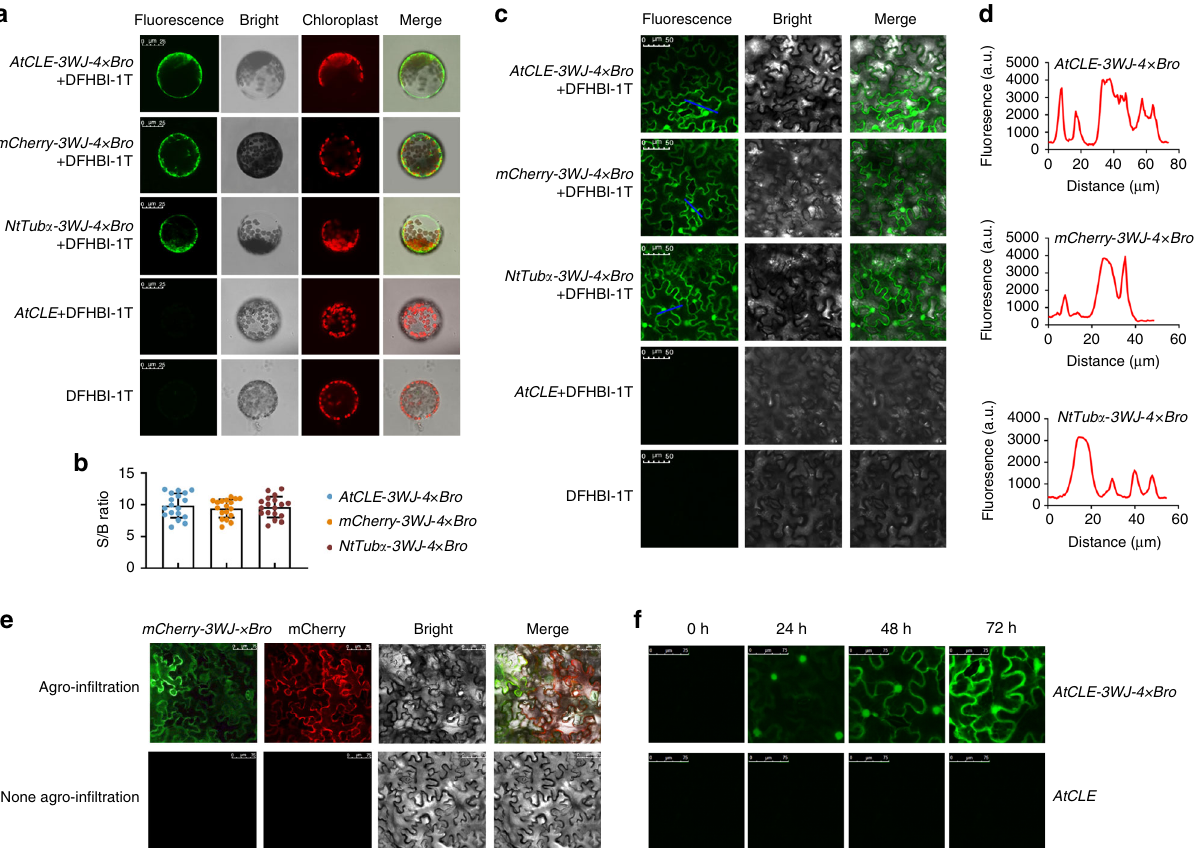
Fig. 5 Use of 3WJ-4 × Bro to report target genes expression in plant. a Confocal imaging of N. benthamiana protoplasts expressing three 3WJ-4 × Bro- tagged mRNAs. Scale bars, 25 μ m. b Signal-to-background ratio of fl uorescence in protoplasts incubated with 10 μ M DFHBI-1T. Error bars, mean ± s.d. ( n = 18). c Representative confocal images of N. benthamiana leaves expressing three 3WJ-4 × Bro-tagged mRNAs. Scale bars, 25 μ m. d Detection of fl uorescence and background in leaf cells. The blue lines in c were used for the line scan in d . e Simultaneous detection of mCherry-3WJ-4 × Bro mRNA and mCherry protein in N. benthamiana leaves by confocal laser microscopy. RNA of mCherry - 3WJ-4 × Bro was imaged at 488-nm excitation and 527-nm emission and mCherry protein at 560-nm excitation and 610-nm emission. Scale bars, 75 μ m. f Confocal microscopy detection of dynamic nuclear export process of NtTub α mRNA with 3WJ-4 × Bro in N. benthamiana leaf cells at 0, 24, 48, and 72-h post in fi ltration, respectively. Scale bars, 75 μ m. All experiments were repeated three independent times with the same conclusion. Source Data are provided as a Source Data fi